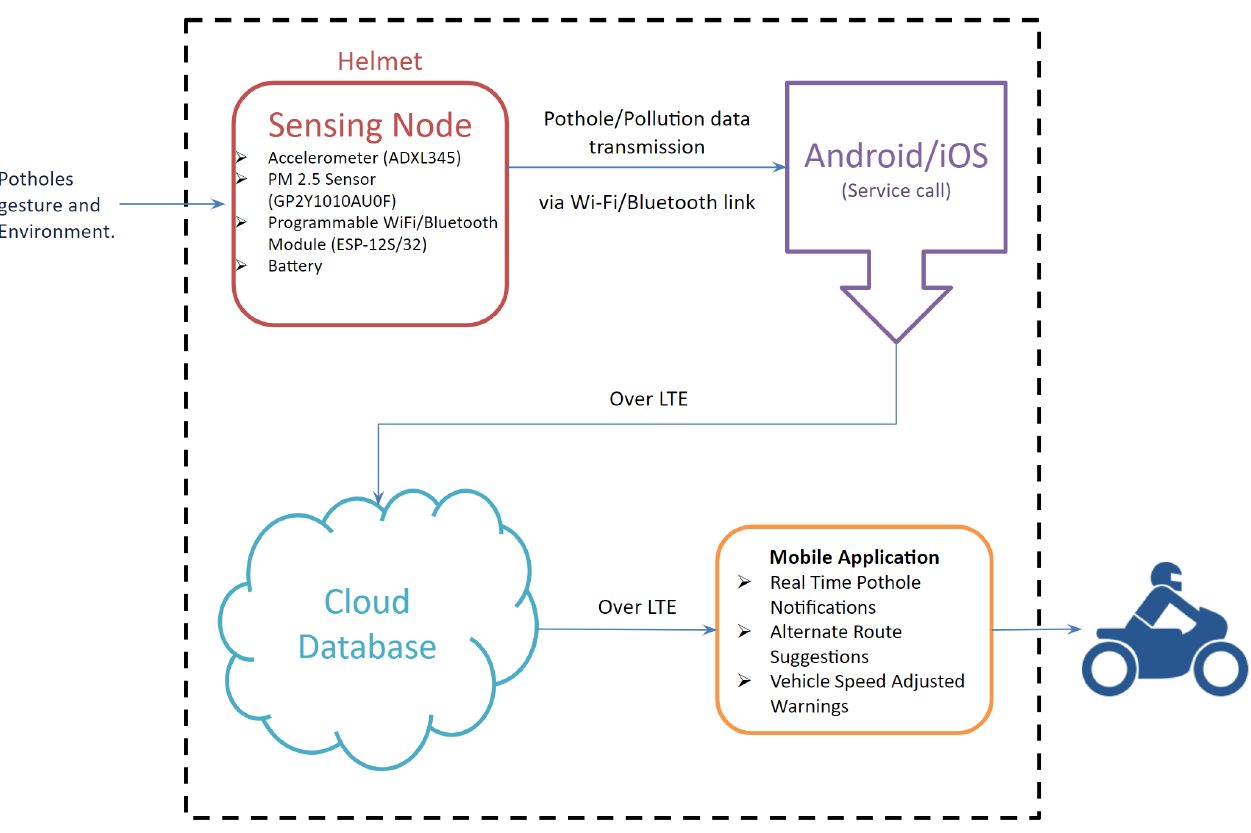
Figure 1. System architecture of SmartPPM system.